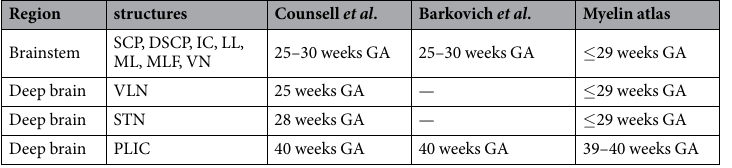
Table 1. Comparison of myelination milestones between the spatio-temporal atlas (Myelin atlas) and the qualitative description 4,21 . The milestone refers to first time-point in gestation when the myelin is identified in a new site. The full names of the structures are provided in the section “Segmentation Protocol”.